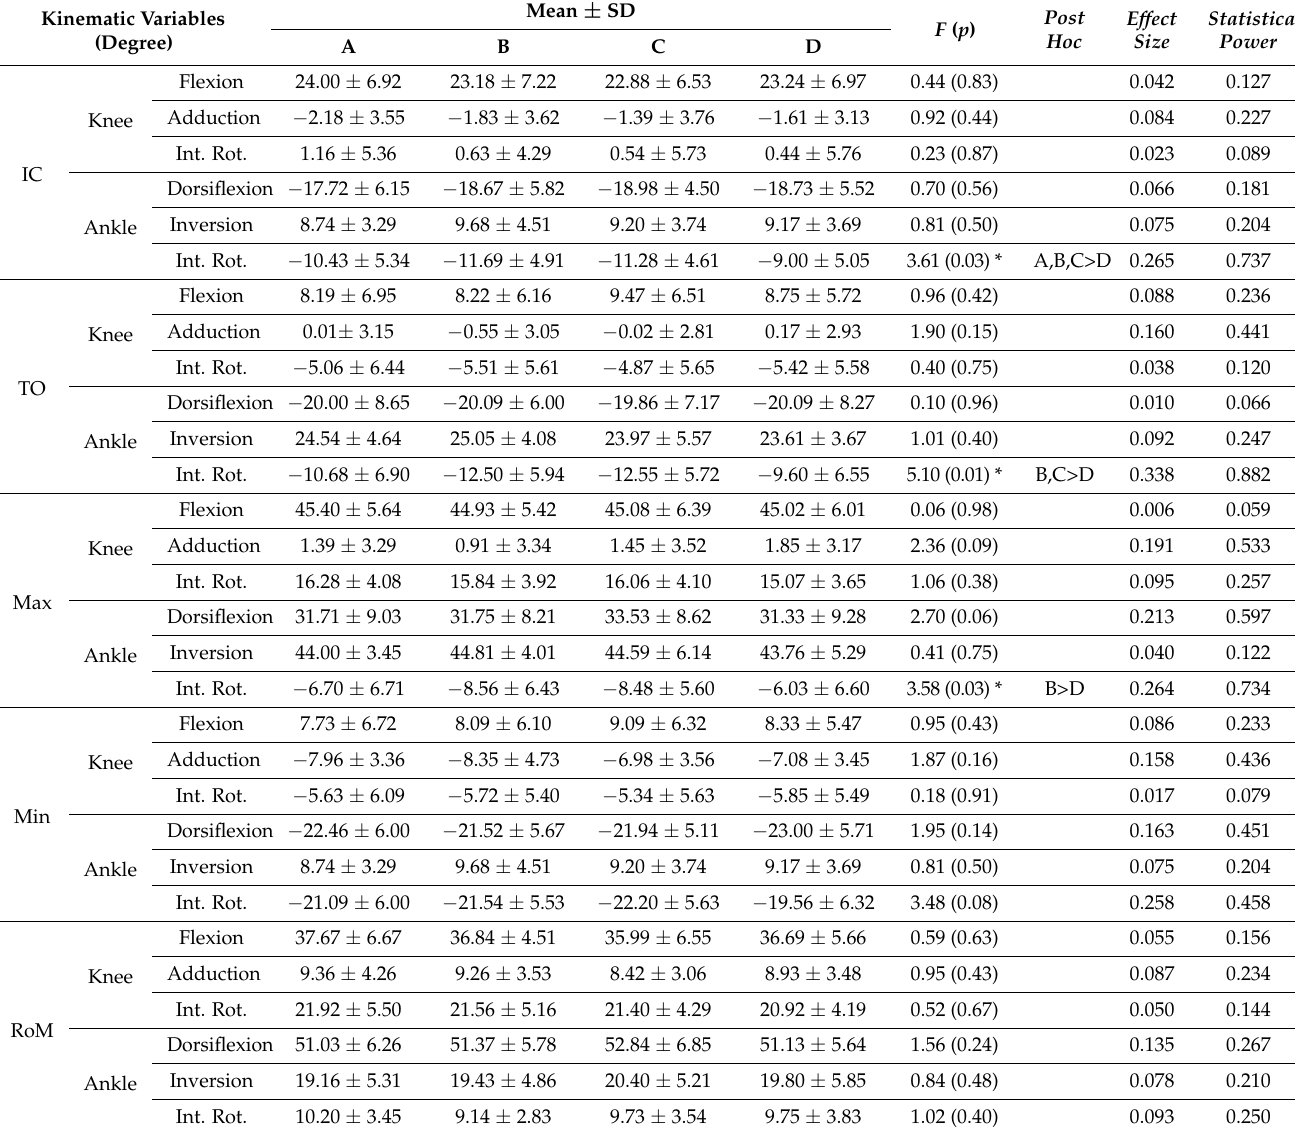
Table A2. Joint angles upon side braking motion in a biomechanical